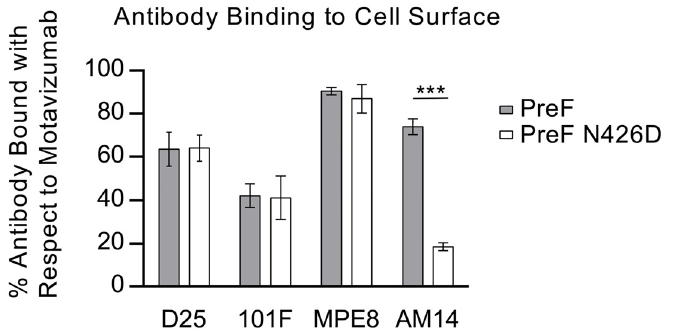
Fig 3. N426D disrupts binding of AM14 to prefusion F. Relative binding of D25, 101F, MPE8 and AM14 to cell surface-expressed prefusion F (grey) or prefusion F containing the AM14 escape mutation, N426D (white) was measured by flow cytometry. Data were normalized to motavizumab binding. Binding of D25, 101F and MPE8 to N426D was comparable to wild-type prefusion F, whereas AM14 binding to N426D was reduced four-fold ( n = 3, P < 0.001; Tukey ’ s HSD, error bars show standard deviation).